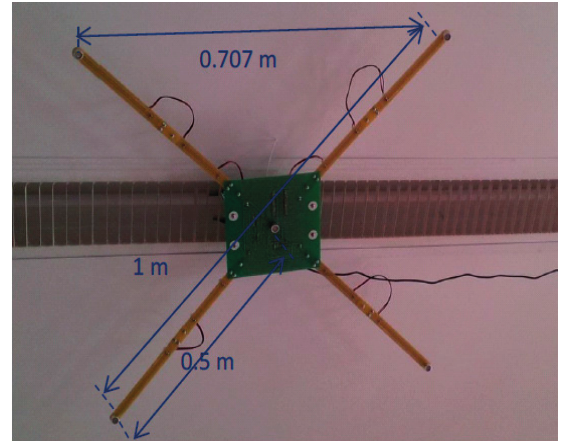
Figure 10. Structure of a real